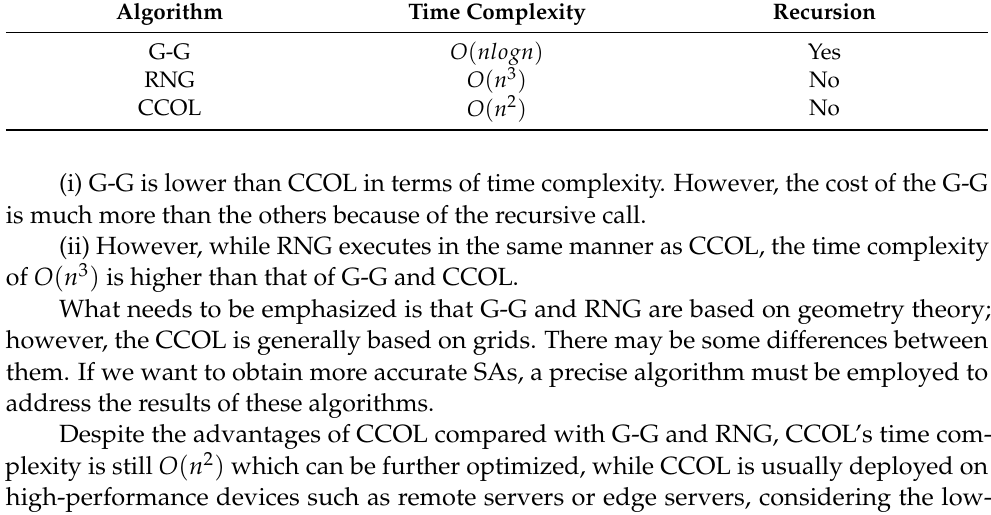
Table 1. Performance comparison.